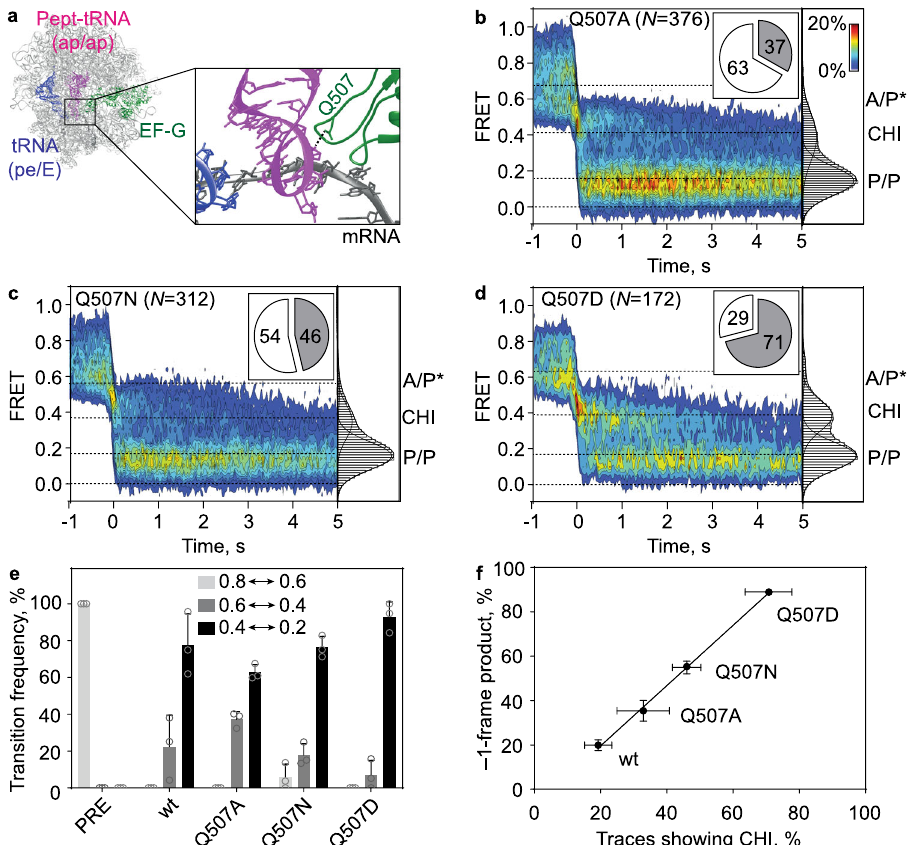
Fig. 2 Frameshifting-prone translocation with EF-G(Q507) mutants. a Schematic of an EF-G – ribosome complex in CHI state (adapted from PDB 4W29 45 ). Pept-tRNA (magenta) and deacylated tRNA (blue) are in CHI states. The zoom-in shows residue Q507 at the tip of domain 4 of EF-G (green) in contact with the anticodon loop of pept-tRNA. The ribosome is shown in gray and the mRNA in black. b – d Contour plots showing the distribution of FRET values during translocation on slippery mRNA mediated by EF-G(Q507A) (b), EF-G(Q507N) ( c ), and EF-G(Q507D) ( d ). Histograms at the right show distribution of FRET values after synchronization to the fi rst transition below FRET 0.5. Pie charts indicate percentage of smFRET traces showing prolonged fl uctuations between CHI and P/P states (dark gray) during translocation. Data are from at least four independent experiments ( N = 4 for Q507A, N = 5 for Q507N, and N = 9 for Q507D). e Transition frequency between FRET states during translocation on slippery mRNA with Q507 mutants and EF-G(wt) (Supplementary Fig. 2 and Table 1). After addition of EF-G, transitions between FRET 0.4 (CHI) and 0.2 (P/P) states are predominant. Shown are mean values with error bars representing the standard deviations. Data are from at least three independent experiments ( N = 3 for PRE, N = 12 for wt, N = 4 for Q507A, N = 5 for Q507N, and N = 9 for Q507D). f Correlation between frameshifting ef fi ciency and the fraction of ribosomes sampling CHI states during translocation on slippery mRNA (Supplementary Fig. 3). Frameshifting ef fi ciencies were measured at 22 °C to match the conditions of the smFRET experiments. Shown are mean values with error bars representing the standard deviation. Black line indicates a linear fi t with the slope of 1.3 ± 0.1, R 2 = 0.9982. Frameshifting ef fi ciencies are from three independent experiments ( N = 3). The percentage of traces with CHI states is derived from at least three independent experiments ( N = 12 for wt, N = 4 for Q507A, N = 5 for Q507N, and N = 9 for